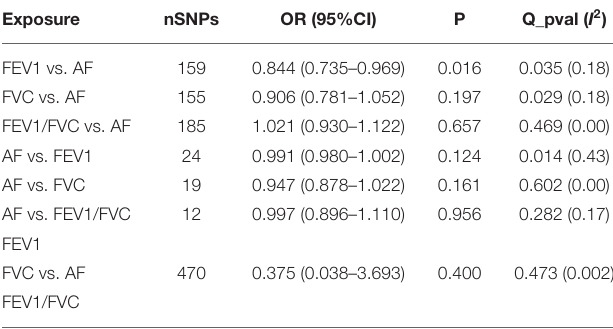
TABLE 6 | Main results of the replication MR analyses.